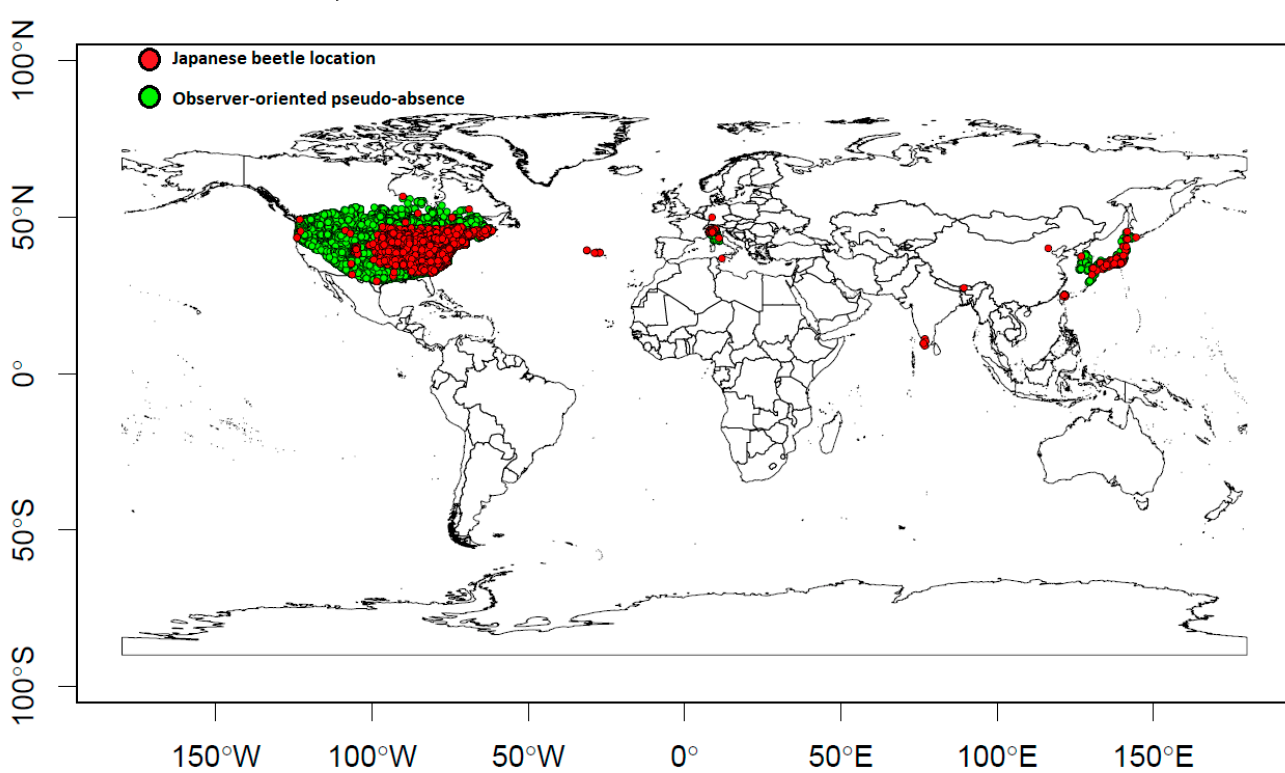
Figure 1. Study area, the world. Target species locations in red, total observer-oriented pseudo-absences (i.e., observances from locations other than target species, collected by the observers of the target species) in green.